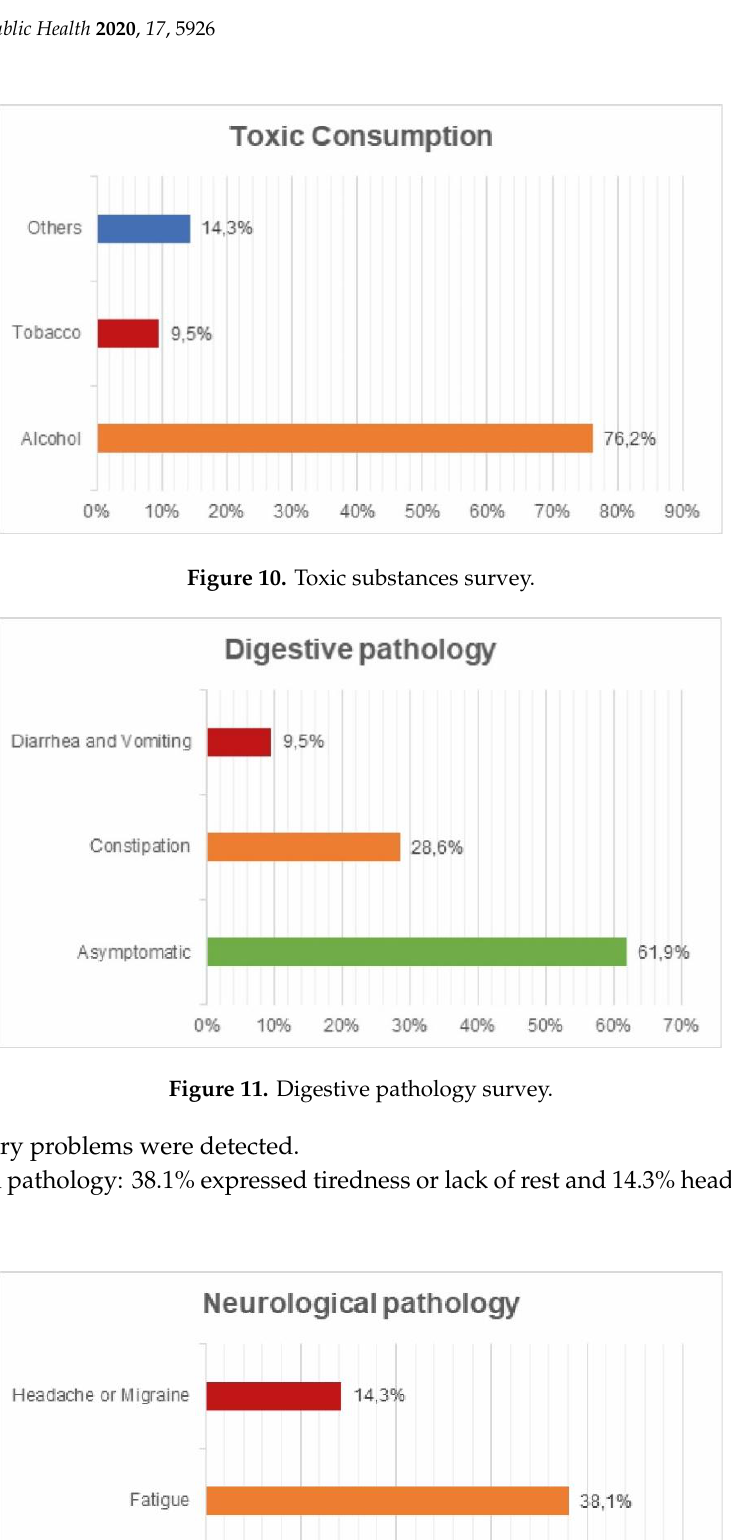
Figure 9. Body mass index value survey.